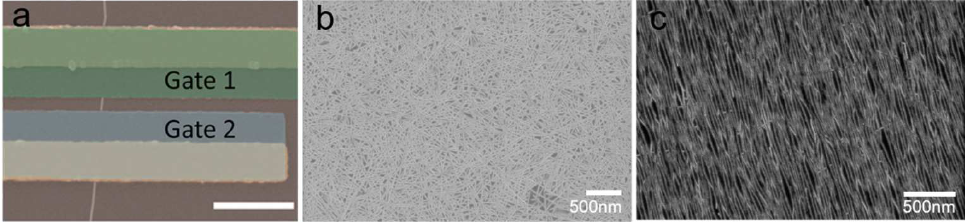
Figure 4. Morphology of single-walled carbon nanotubes. ( a ), Single carbon nanotube [48]. (Copyright © 2015, ACS Nano. ( b ), semiconducting CNT network film. ( c ), Aligned CNT arrays.